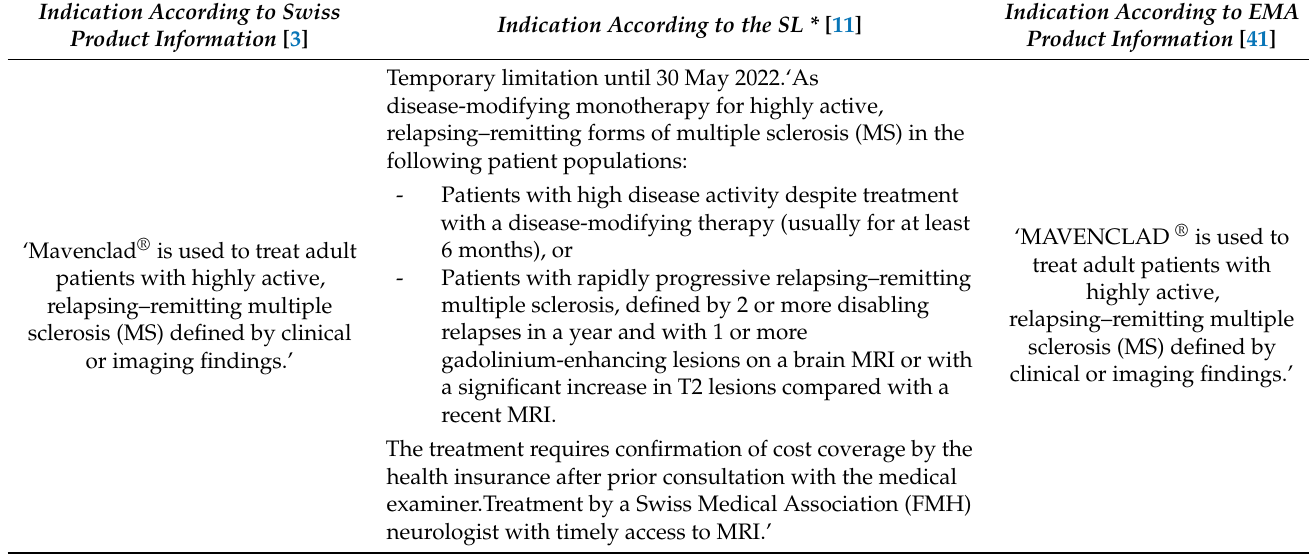
Table 9. Cladribine (Mavenclad ®